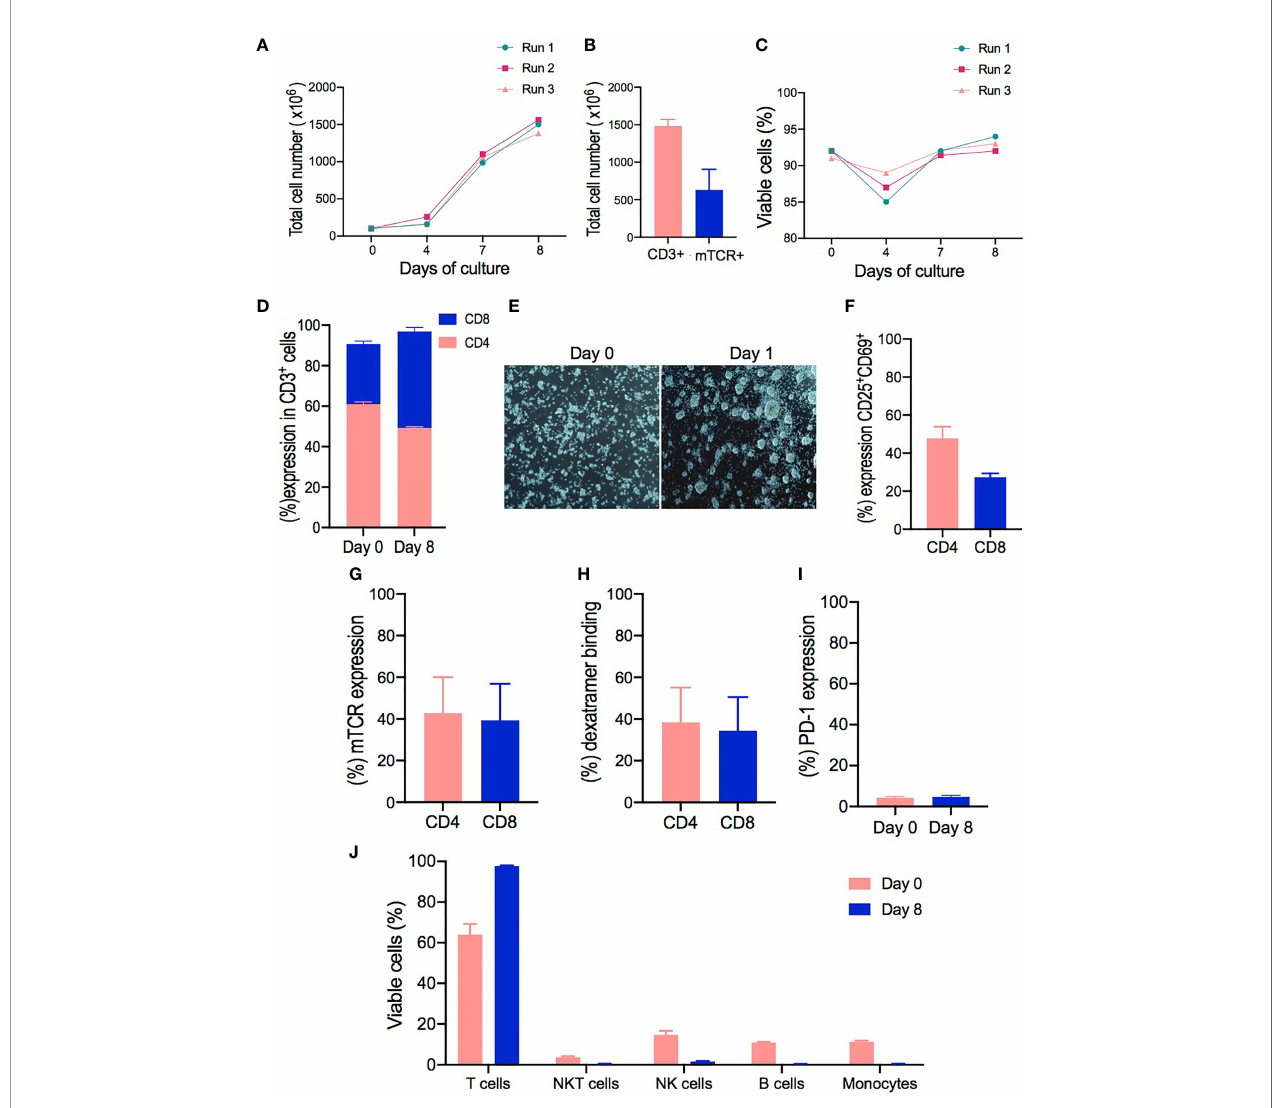
FIGURE 3 | Clinical-grade manufacturing of T cell receptor (TCR)-T cells using the CliniMACS Prodigy. (A – C) Total cell numbers and cell viability of cell products from healthy donors (HD1-3) performed on days 0, 4, 7, and 8 of cell expansion. (D) CD4 and CD8 T cell ratios at the start of culture (day 0) compared to the end of culture (day 8). (E) Representative pictures from cell cultures taken with the internal camera of the CliniMACS Prodigy on day 0 and at 24 h after activation (day 1) under static culture conditions. (F) Activation status of CD4+ and CD8+ T cells after 24 h of activation as evaluated by fl ow cytometry analysis for the co-expression of CD25 and CD69 surface markers. (G) Transduction ef fi ciency of redirected TCR-T cells represented by the percentage of mTCR expression in CD4+ and CD8+ cells on day 8. (H) Percentage frequencies of dextramer-speci fi c binding in CD4+ and CD8+ transduced T cells. (I) Comparison of PD-1 expression evaluated on cells from starting material (day 0) and expanded transduced T cells (day 8). (J) Cell composition of starting material on day 0 and expanded fi nal product on day 8 as assessed by fl ow cytometry to identify the percentage frequencies of lymphocyte T cells (CD3+), monocytes (CD14+), B cells (CD20+), NK cells (CD3-CD56+), and NKT cells (CD3+CD56+). The results are shown as mean ± SD for three independent healthy donors ( n =